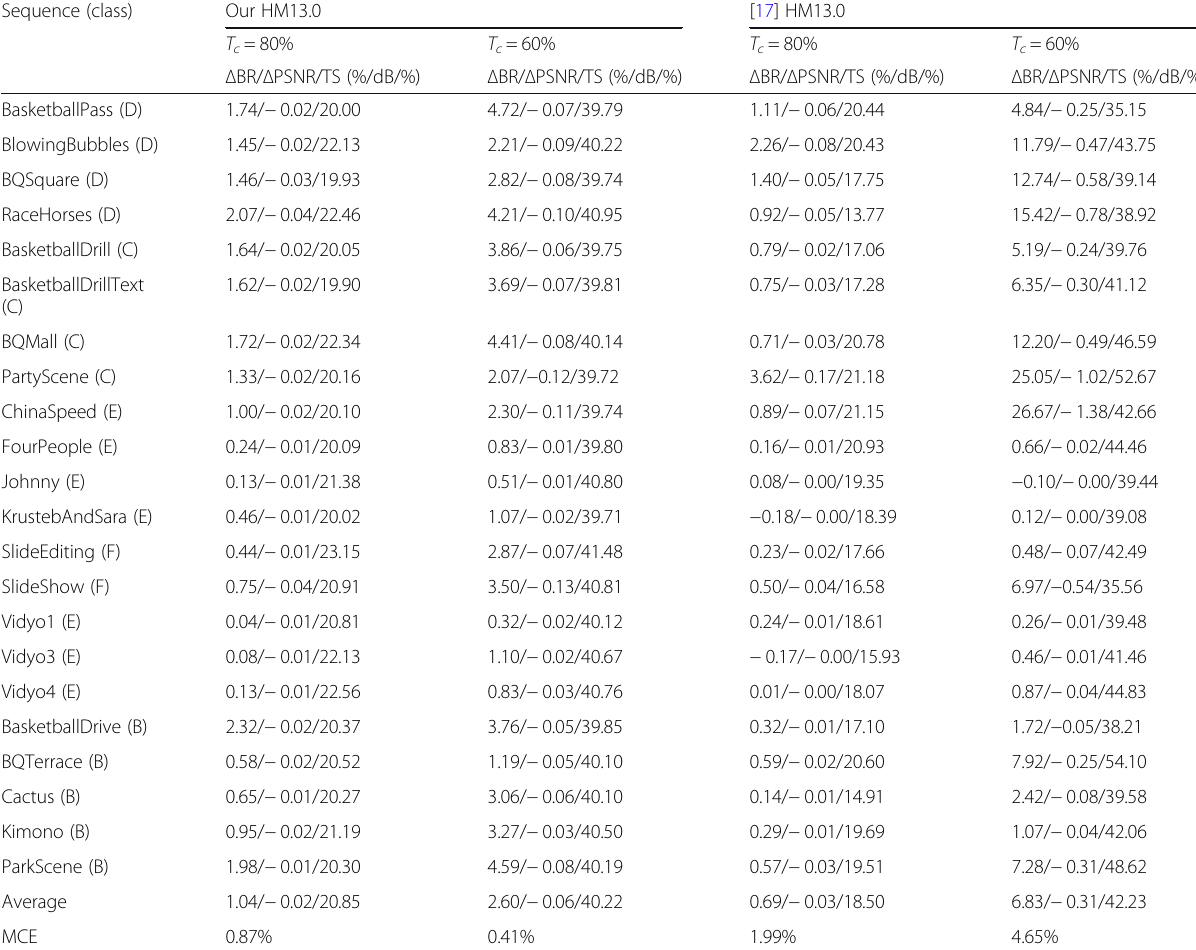
Table 7 Performance comparison between the proposed algorithm and [17] Sequence